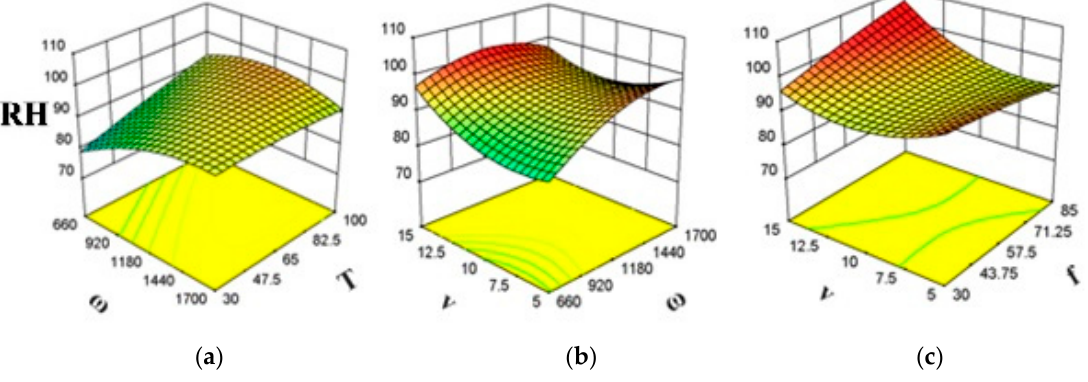
Figure 3. Significant interaction for composite’s RH ( a ) ω T , ( b ) v ω , and ( c ) vf.